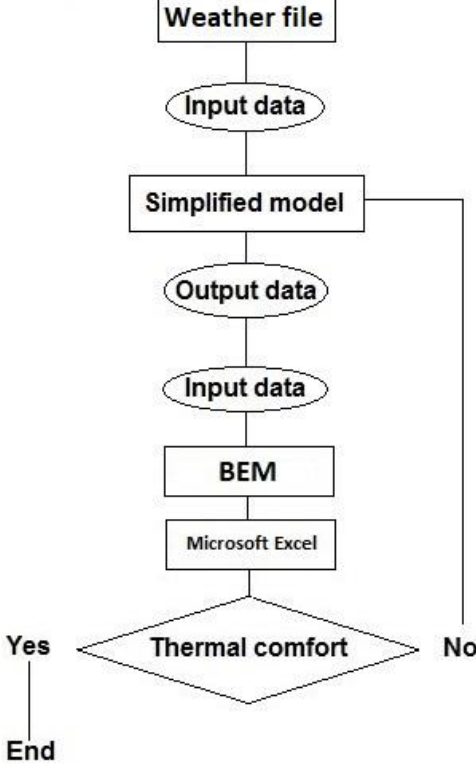
Figure 2. Top-down calculation method of indoor thermal comfort considering an urban heat island by using a simplified numerical model.